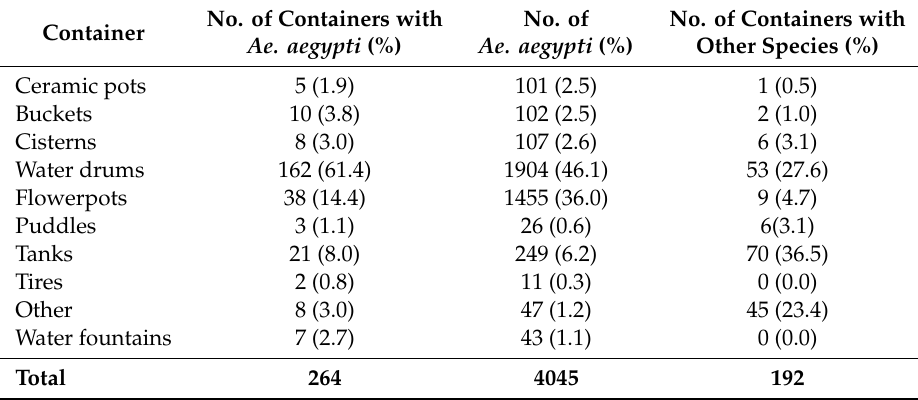
Table 2. Positive containers for Aedes aegypti